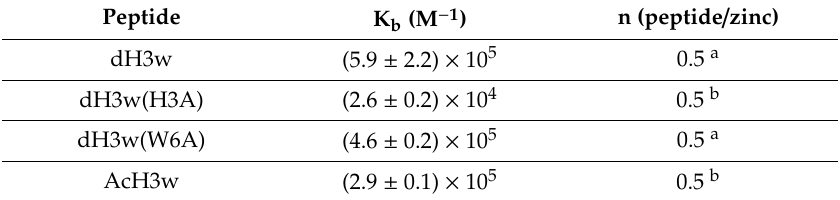
Table 2. Binding constant (K b ) and stoichiometry (n) for the Zn / peptide